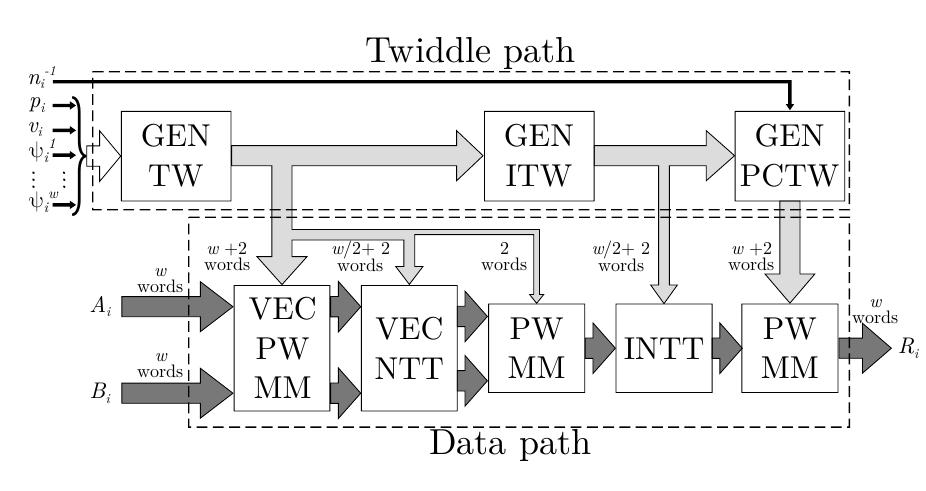
Figure 1: Residue Polynomial Multiplier (RPM)